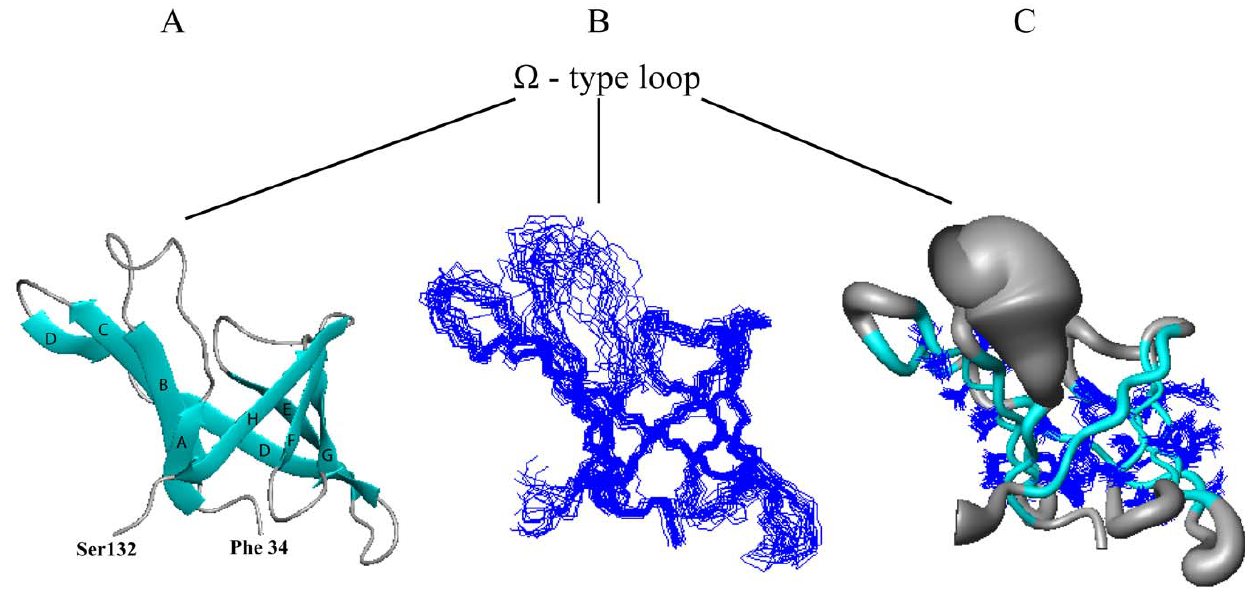
Figure 2. NMR structure of the soluble domain of lipoprotein YxeF. Only residues 34–132 are shown because the terminal polypeptide segments are flexibly disordered in solution. The N-terminal residue Phe 34 and the C-terminal residue Ser 132 are labeled. Lines point at the V -type loop, which connects b -strands A and B and is poorly defined in the NMR structure. (A) Ribbon drawing of the first conformer of PDB entry 2JOZ with b -strands being depicted in cyan. (B) Superposition of the 20 conformers representing the NMR solution structure obtained after superposition of the backbone heavy atoms (N, C a and C’) of the b -strands. (C) ‘‘Sausage’’ representation of backbone and best-defined side chains: a spline function was drawn through the mean positions of C a atoms with the thickness being proportional to their mean global displacement in the 20 conformers after superposition as in B). The figure was generated using the program MOLMOL [59].